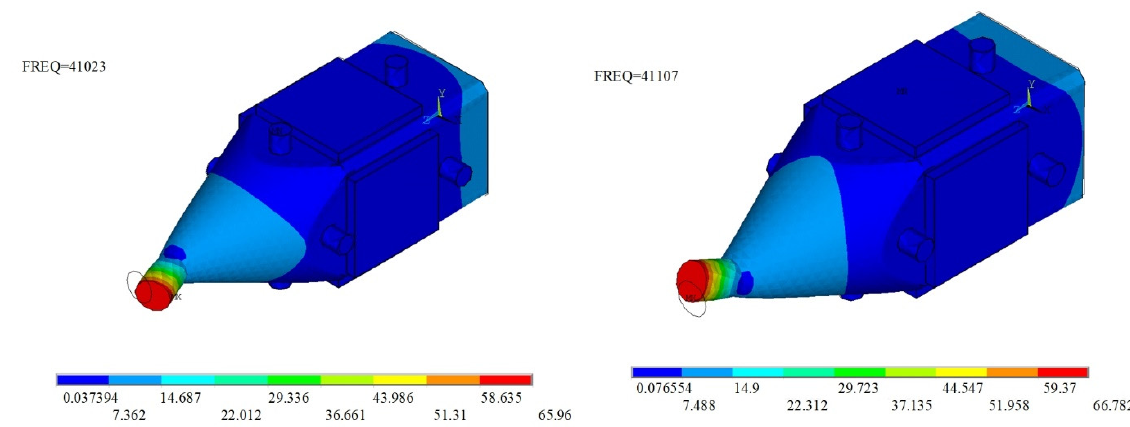
Figure 4. Bending vibration modes in OX and OY directions.